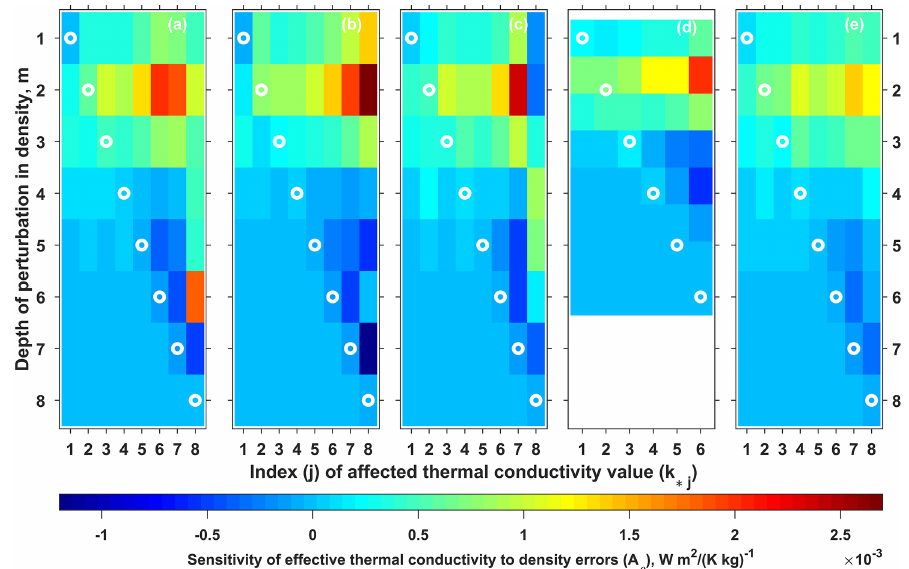
Figure 7. Sensitivity ( A ρ in Eq. 28) of effective thermal conductivities k ∗ j to errors in density. Panels correspond to different calculation domains: spring 2012 (a) , spring 2013 (b) , spring 2014 (c) , autumn 2014 (d) and spring 2015 (e) . In all panels the colour of a point in column j and depth z shows the feedback of effective thermal conductivity value k ∗ j found at the depth highlighted by the white circle to a unit error in density (1kgm − 3 ) made at depth z .